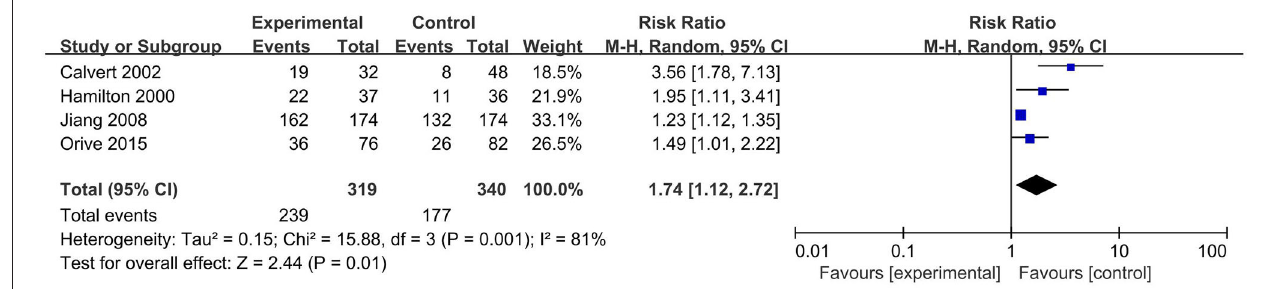
FIGURE 3 | Meta-analysis of the effect of psychological interventions on symptom improvement. CI, confidence